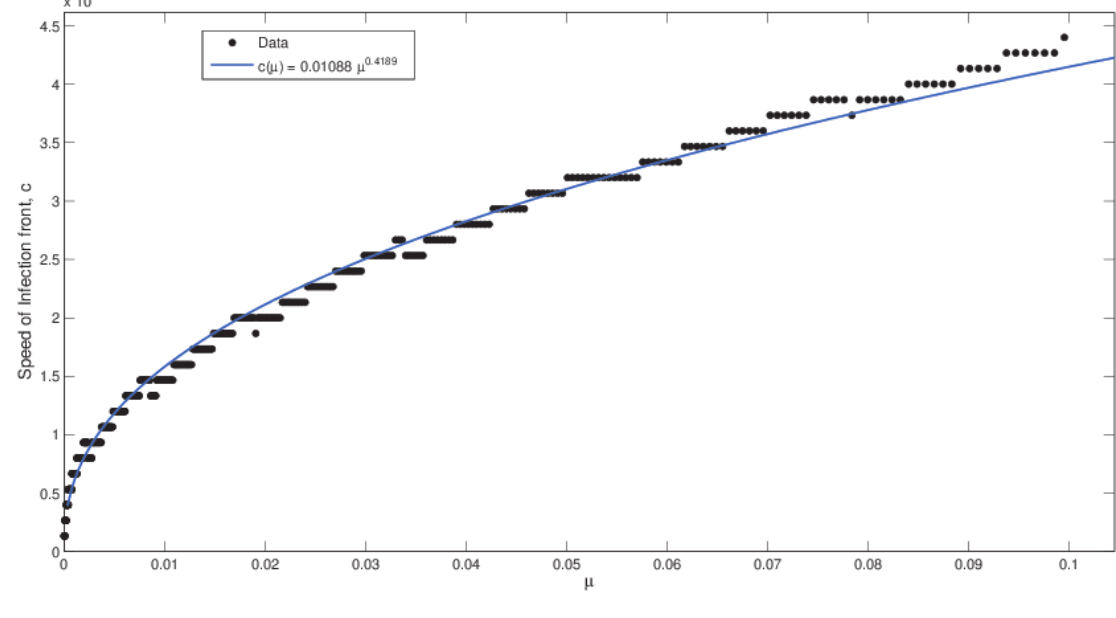
Fig. 11. The speed of the infection front for different values of µ , for solutions of model (33) initiated with levels of inoculum and disease at the level of EE 2 on the left boundary. The parameter values in Table VIII were used. Clearly the equation c ( µ ) = 0 . 01088 µ 0 . 4189 fits the data